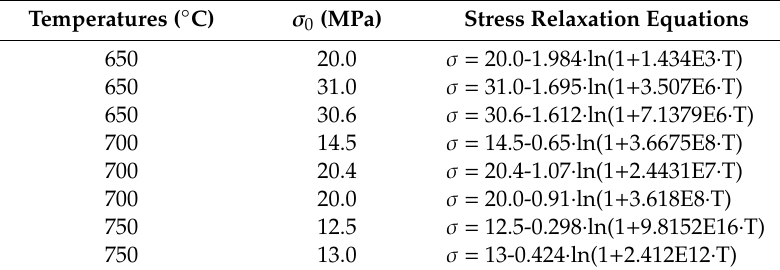
Table 2. Stress relaxation equations under different temperatures.